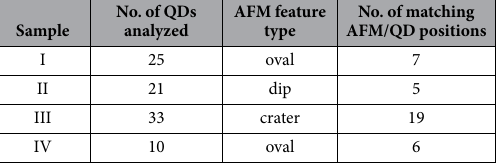
Table 1. Summary table of the photoluminescence/atomic force microscopy results obtained from the measurements carried out on the different samples under study. The number of QDs that have been analyzed (photoluminescence positioning, spectral characterisation, and atomic force microscopy), the type of surface features observed with the atomic force microscope (examples of “oval, “dip” and “crater” features are shown in Figs 2d, 3c (first column), 3c (second column) respectively), and the number of instances in which the stated AFM surface feature type was observed in proximity to the QD’s emitting dipole are